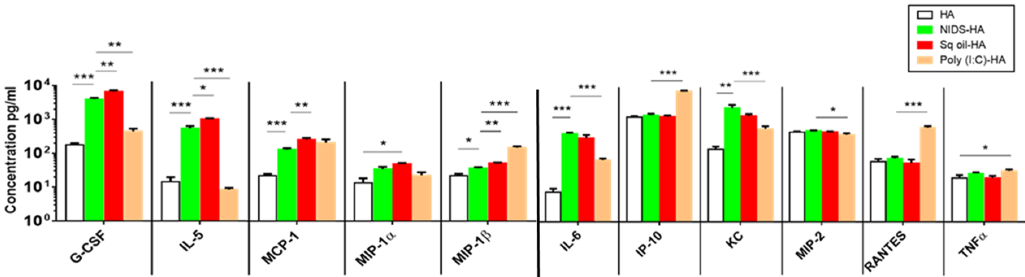
Figure 1. Adjuvant effects of Natural Immune-enhancing Delivery System (NIDS) vs. other adjuvants on early innate pro-inflammatory cytokines and chemokines in BALB/c mice following a single Intra-muscular (IM) vaccination. Comparison of early innate cytokine and chemokine (G-CSF, IL-5, MCP-1, MIP1, MIP-1 β , IL-6, IP10, KC, MIP-2, RANTES, and TNF α ) responses measured in